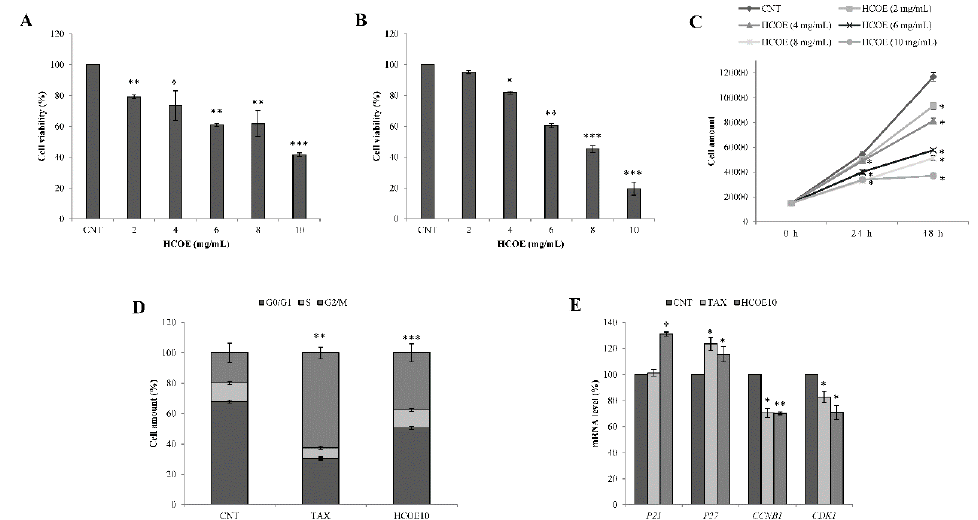
Figure 2. A375 cell growth and cycle. A375 cell viability was measured after 24 h ( A ) and 48 h ( B ) of treatment with 2, 4, 6, 8, and 10 mg/mL HCOE. Results, expressed as percentage with respect to the PBS control (CNT; considered as unit, 100%), represent the mean ± SD of four independent experiments (* p < 0.05; ** p < 0.01; *** p < 0.001 vs. control). ( C ) Proliferation curves of A375 cells were generated by counting, with a Neubauer modified chamber, the amount of alive cells after staining with Trypan Blue at 0, 24 and 48 h of treatment with HCOE. Results were indicated as mean ± SD of three independent experiments (* p < 0.05 vs. control). ( D ) A375 cell cycle analysis after 48 h of treatment with paclitaxel (TAX) or 10 mg/mL HCOE is shown. For each sample, the percentage amount of cells in every cycle phase (G0/G1, S and G2/M) was measured by cytofluorimetric analysis. Results are expressed as mean ± SD of three independent experiments (** p < 0.01; *** p < 0.001 vs. control). ( E ) P21, P27, CCNB1, and CDK1 mRNA levels, measured by RT-PCR, in A375 cells treated for 48 h with TAX or 10 mg/mL HCOE are reported. Gene expression, calculated as mRNA amount after normalization for ACTB mRNA (2 - ∆∆ Ct ), is reported as percentage with respect to the PBS control (CNT; considered as unit, 100%). Data represent the mean ± SD of three independent measurements (* p < 0.05; ** p < 0.01 vs. control).